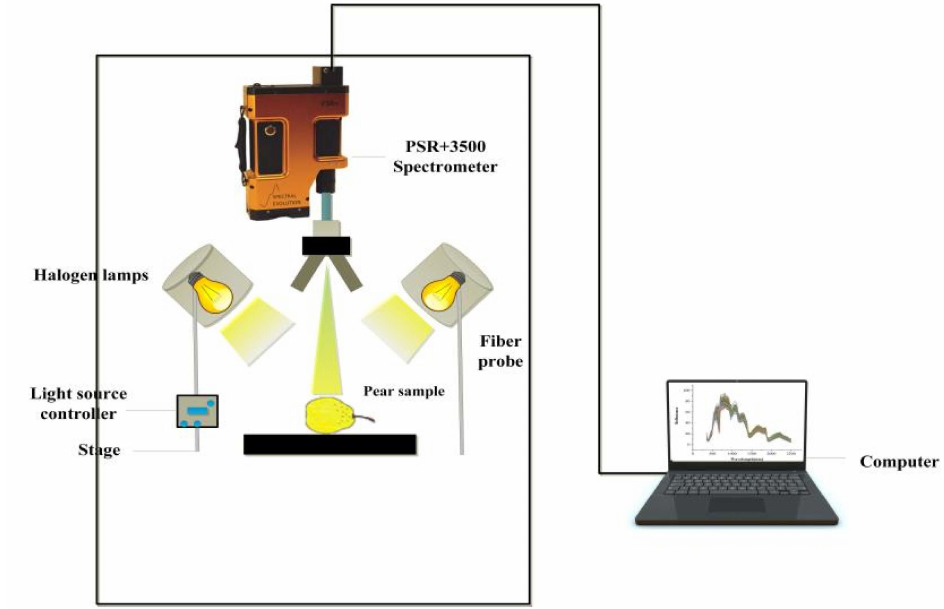
Figure 2. Spectral acquisition